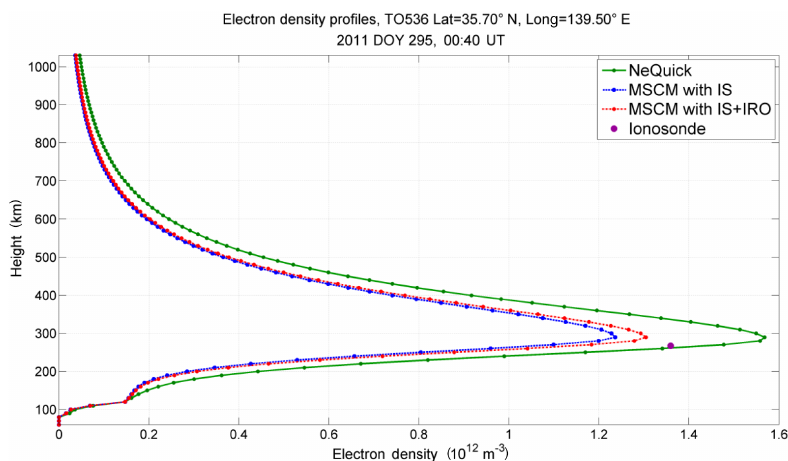
Figure 6. Electron density profiles: NeQuick model (green) and adjusted NeQuick model (blue is assimilation of ionosondes only, red is assimilation of ionosonde and IRO F2 layer data) compared with the independent ionosonde measurement (violet dot).